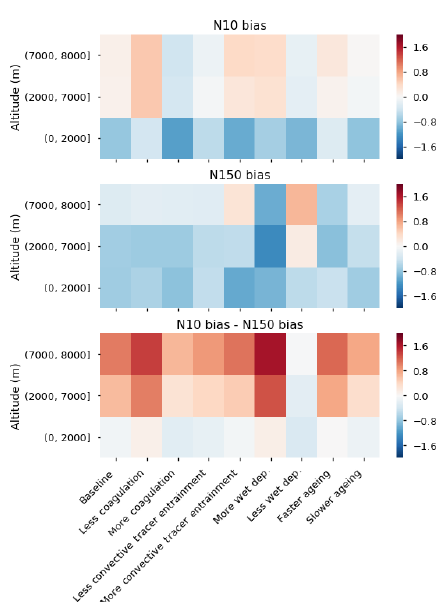
Figure B1. Summaries of the fractional bias (model – obs) in N10 and N150 for each of the sensitivity experiments across three (unequal) altitude ranges. The difference between bias in N10 and N150 is also